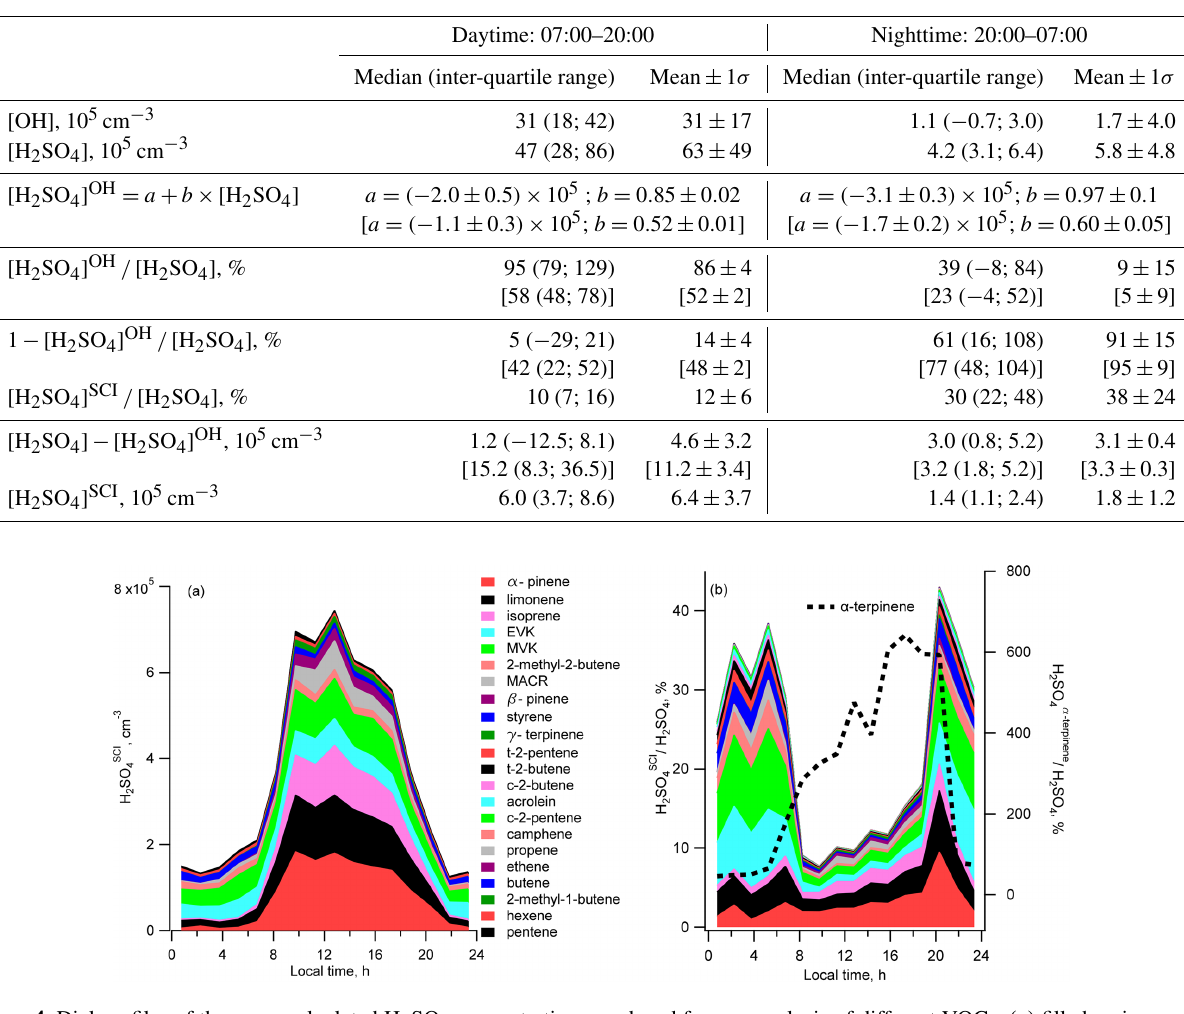
Figure 4. Diel profiles of the mean calculated H 2 SO 4 concentrations produced from ozonolysis of different VOCs: (a) filled regions corre- spond to [H 2 SO 4 ] SCI produced by ozonolysis of different VOCs; (b) profiles of ratios of [H 2 SO 4 ] SCI from different VOCs to the measured [H 2 SO 4 ]. Black dotted line in (b) corresponds to [H 2 SO 4 ] SCI produced by the ozonolysis of α -terpinene (right